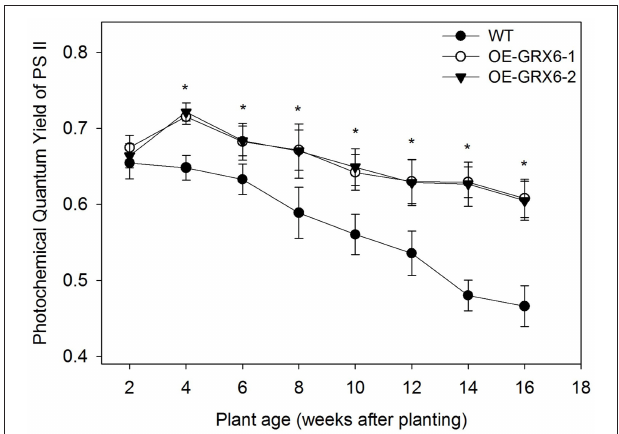
FIGURE 7 | Effect of exogenous cytokinin and gibberellin on the plant growth. Wild-type and transgenic seeds were incubated in the nutrient solution supplemented with 100 µ of GA 3 or/and BAP (6-Benzylaminopurine) for 7 days in the dark at 28 ◦ C (A) . Response of the Wild-type and transgenic plants to different treatments relative to the untreated controls (B) . Data is a mean of 20 seedlings ( ± SD).